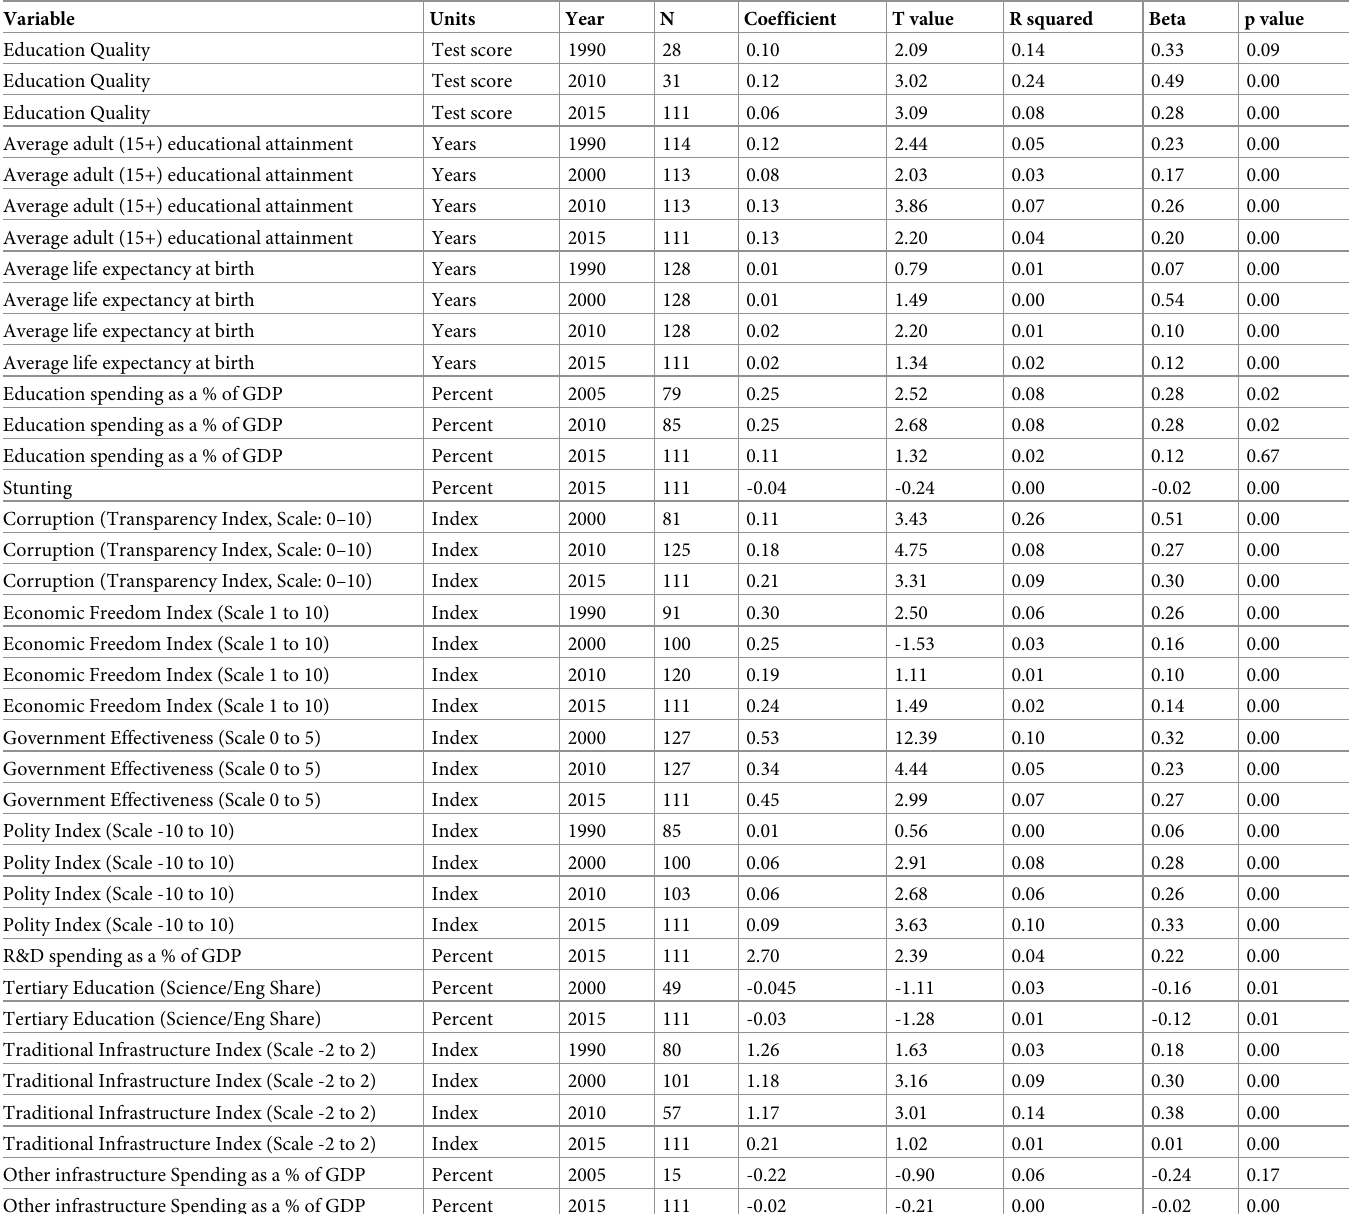
Table 1. Explanatory power for TFP level of IVs after control for GDP per capita at